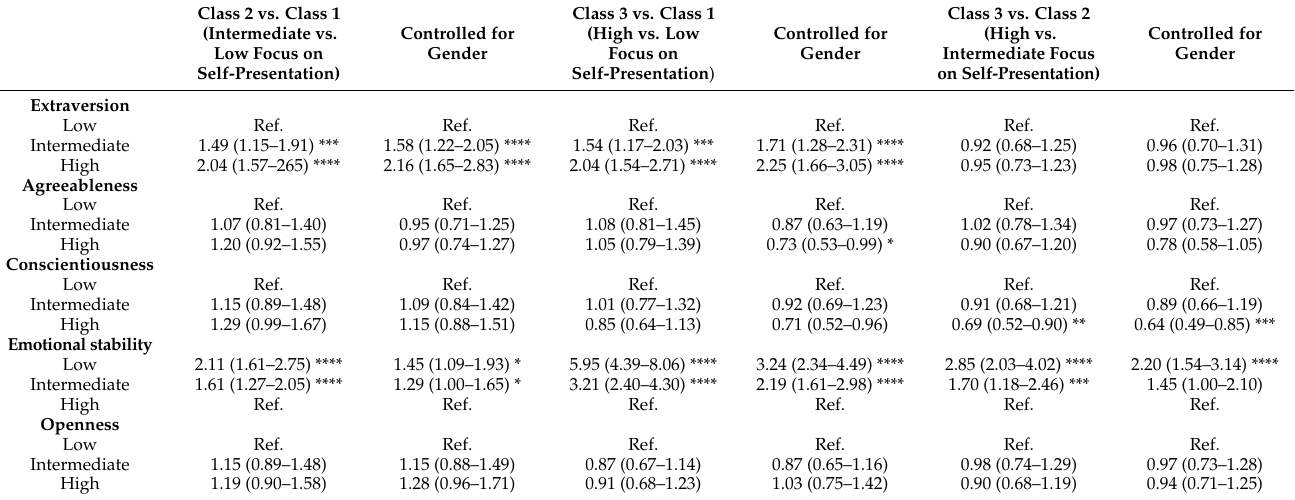
Table 7. Comparison of class belongingness across personality variables.